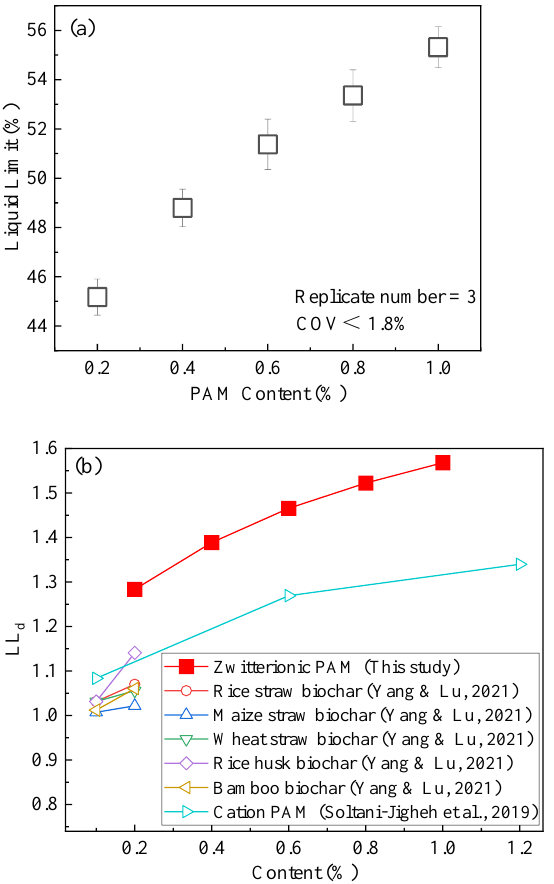
Figure 3. Liquid limit of CCC mixed with ZP. ( a ) Influence of PAM content on the LL of the compacted clay; ( b ) effect of different materials mixed with clay on LL/LL ck of the compacted clay [58,59]. 3.2. WRC The evolution of the moisture content with various ZP contents is shown in Figure 4.